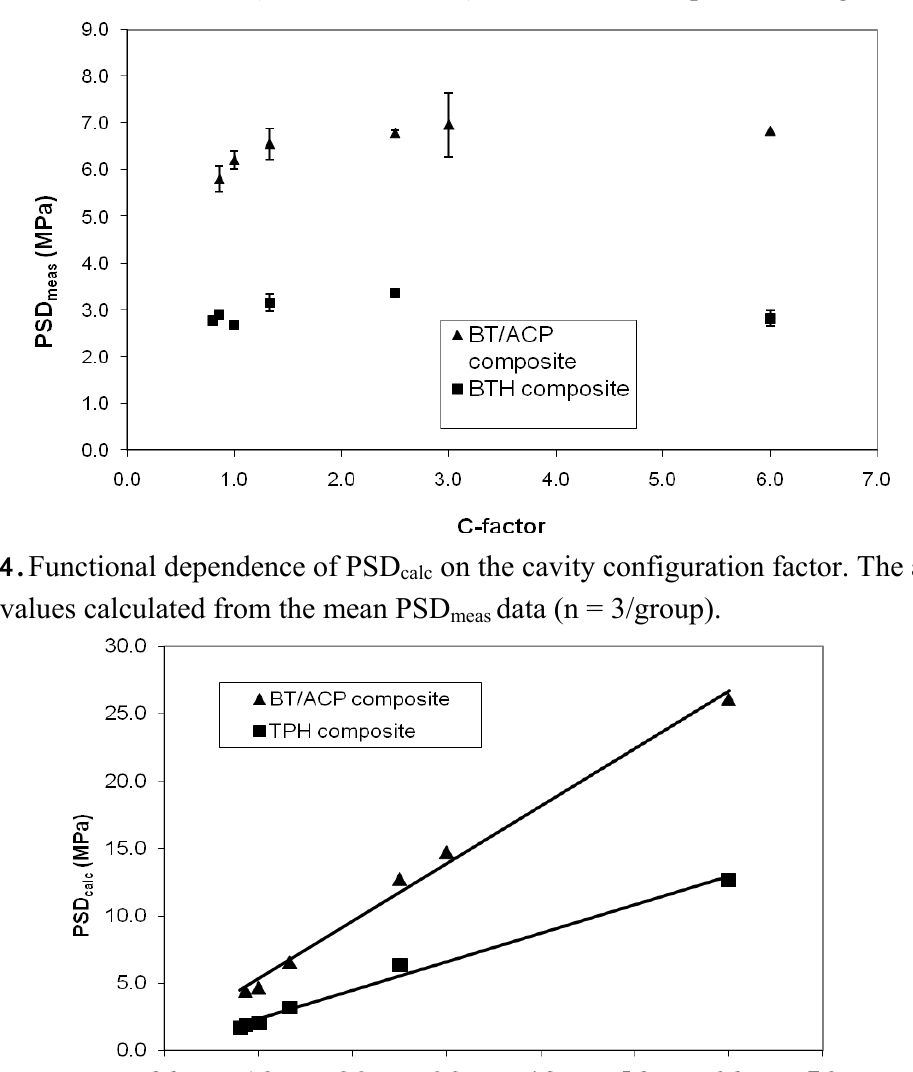
Figure 3. PSD (mean value ± SD) as a function of specimen height. meas